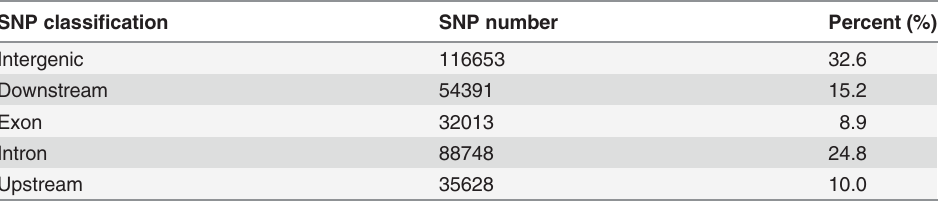
Table 2. Classification of identified SNPs. SNP classi fi cation SNP number Percent (%) Intergenic 116653 32.6 Downstream 54391 15.2 Exon 32013 8.9 Intron 88748 24.8 Upstream 35628 10.0 Intergenic SNPs were identi fi ed from regions between genes, while Downstream and Upstream represents SNPs identi fi ed from regions of downstream and upstream of the